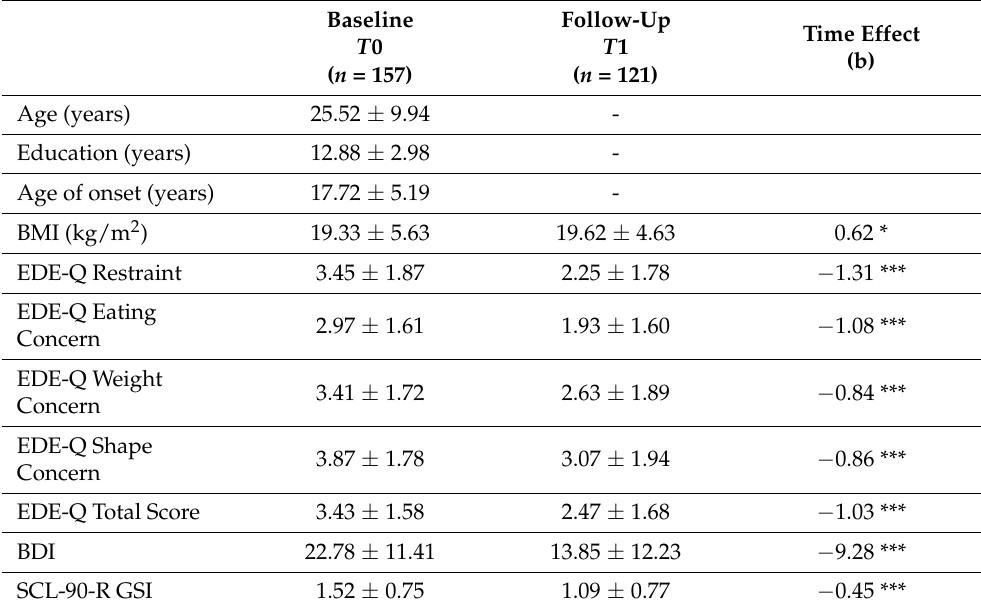
Table 1. Characteristics of the sample at baseline and follow-up. Results of longitudinal analysis in patients are reported using age and BMI-adjusted unstandardized coefficients (time fixed